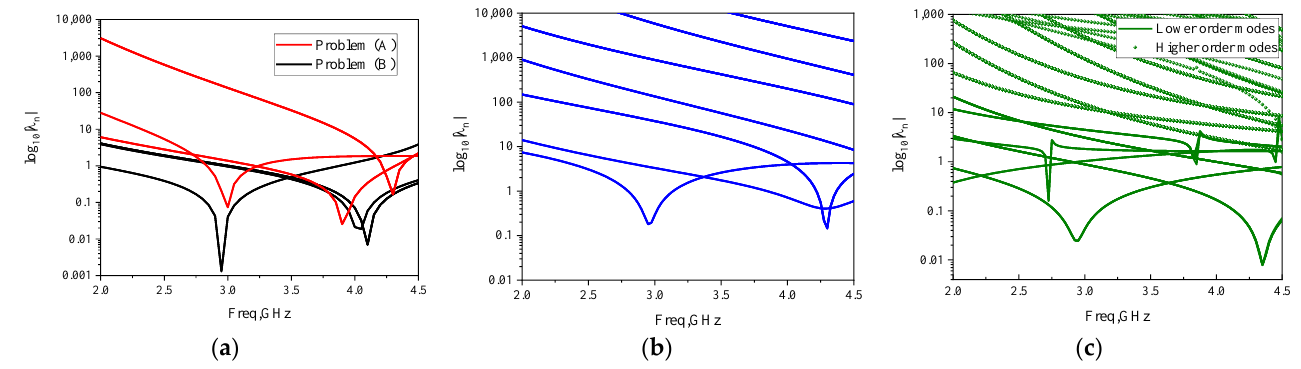
Figure 13. Magnitudes of characteristic eigenvalues of the first 150 lower-order modes in the fre- quency range from 2.0 GHz to 4.5 GHz for the four different problems. ( a ) Problems (A) and (B); ( b ) problem (C); ( c ) problem (D). Table 2. Resonant Frequency (GHz) for Four Different Problems.